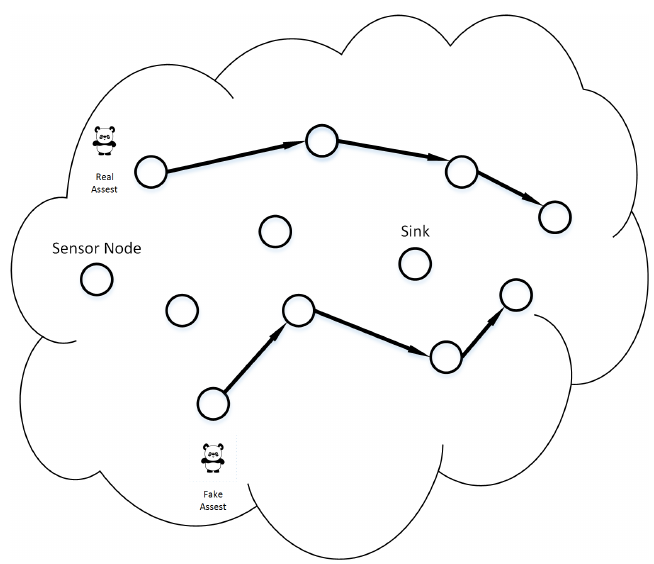
Figure 7. Overview of the fake source technique in